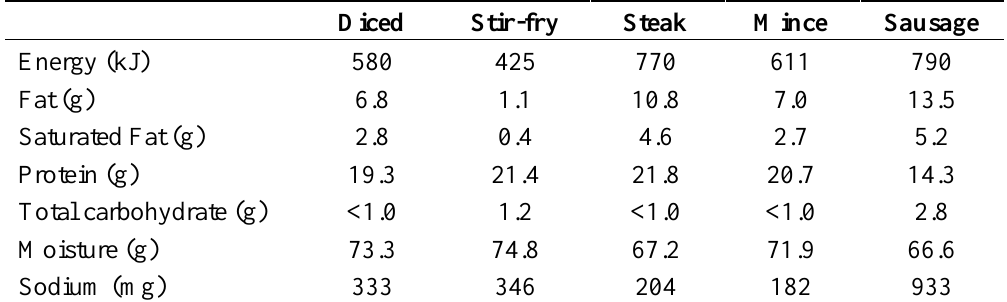
Table 1. Nutritional composition of lean fresh pork per 100g *. Diced